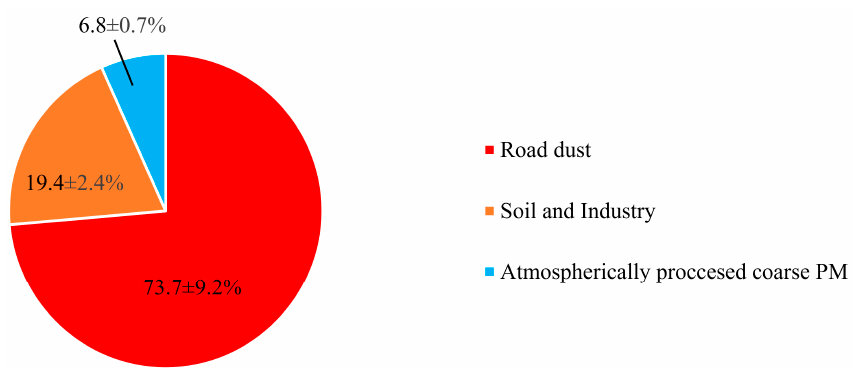
Figure 6. Relative contributions of different sources to coarse PM for the whole sampling campaign.